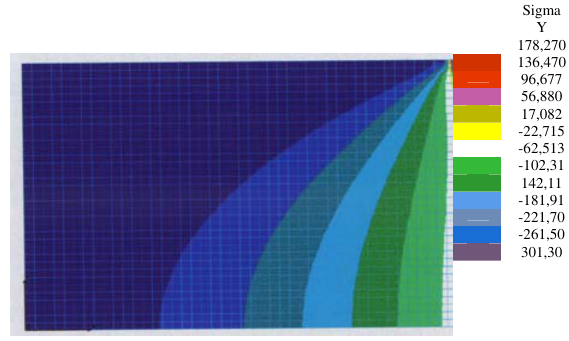
Fig 4 . Distribution of vertical component of stress y σ in the sample if analysed by oedometer with a fixed ring and flexible stamp (linear model)